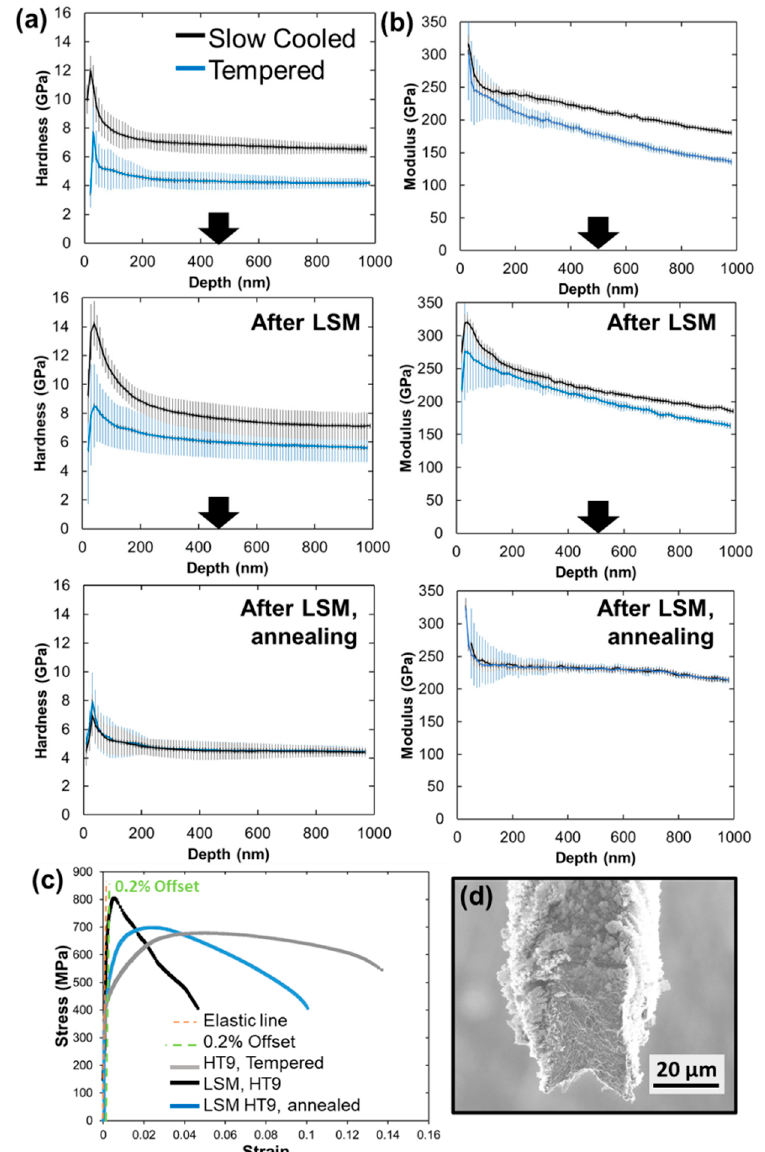
Figure 6. Nanoindentation results showing ( a ) hardness versus displacement and ( b ) modulus versus displacement. Representative plots (taken from one test) of the micro ‐ tensile results ( c ) for the LSM HT9 (sample B) before and after annealing compared to as received HT9. ( d ) Fracture surface for LSM HT9 (sample B) after annealing.